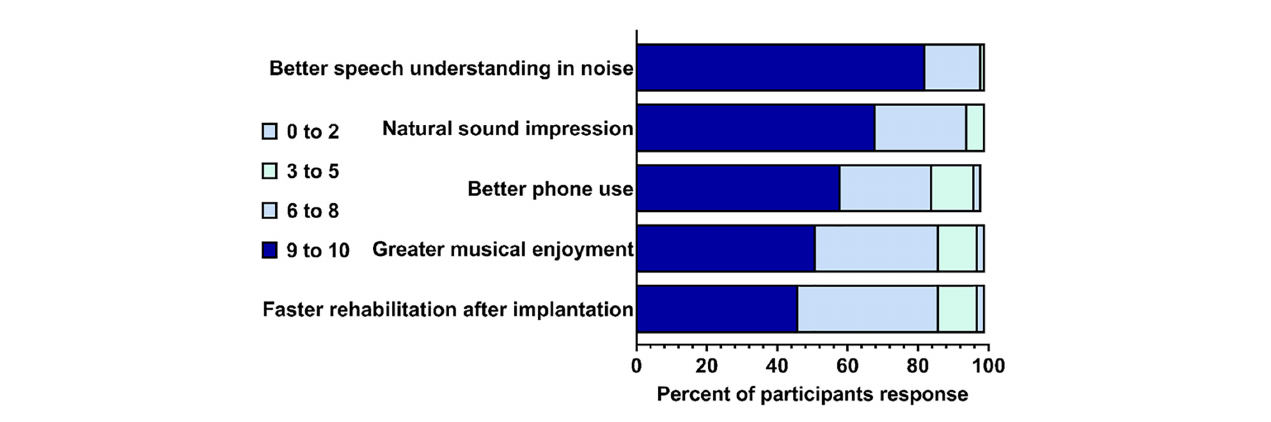
FIGURE1 Participants’ rating of importance for five hypothetical improvements in a new cochlear implant (CI). Percent out of N = 80 completed responses (1 non-respondent). Gray quadrant indicates the percent of participants that rated the improvement from 0 to 2; light green indicates the percent that rated 3–5; light blue indicates that percent that rated 6–8; and dark blue indicated the percent that rated